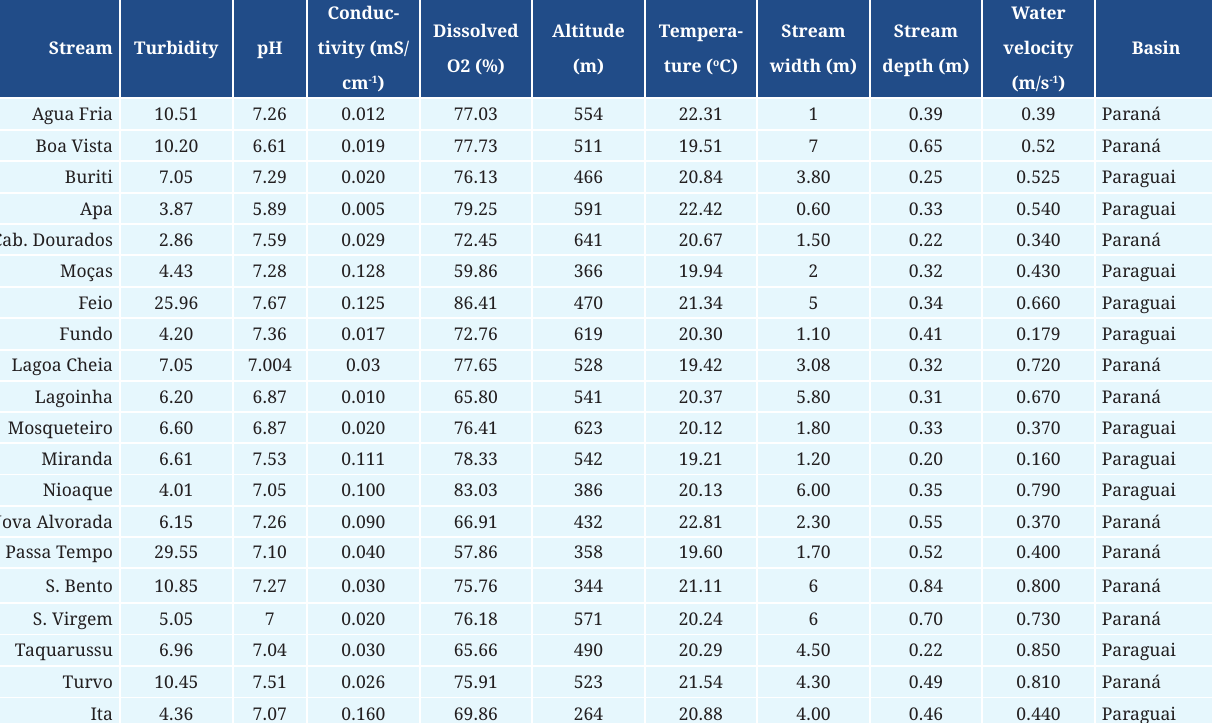
TABLE 1 | Mean values of environmental variables measured in 20 headwater streams of the Paraná and Paraguai River basins.